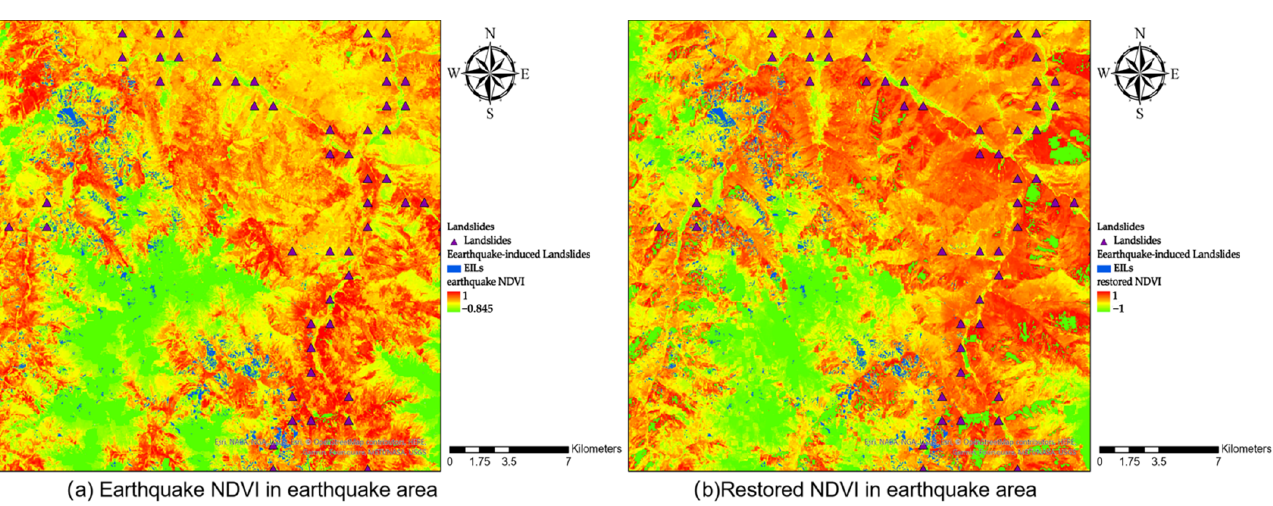
Figure 15. Earthquake NDVI and restored NDVI. ( a ) is the NDVI of EIL areas between August 2017 and December 2017, and ( b ) is the NDVI of EIL areas between August 2021 and December 2021.